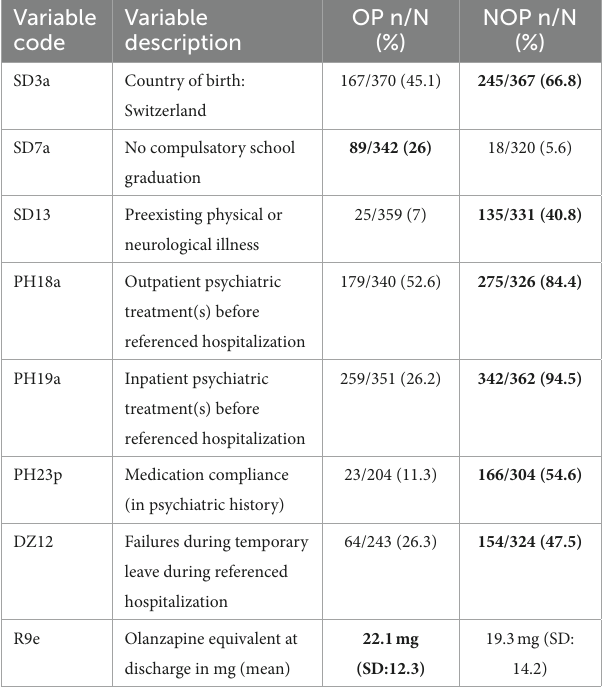
TABLE 4 Absolute and relative distribution of relevant predictor variables. TABLE 5 Performance measures of final gradient boosting model on validation